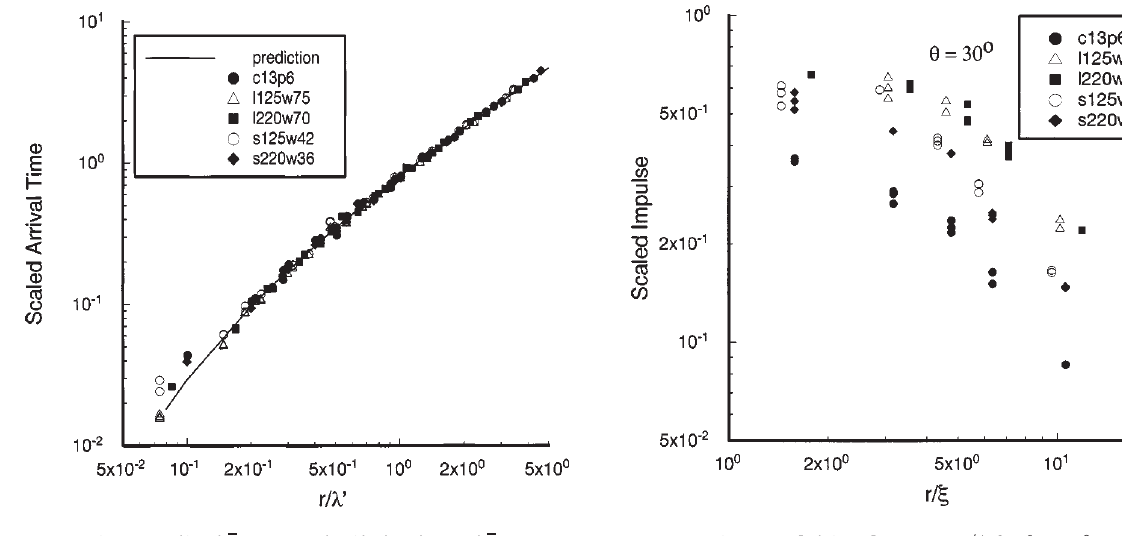
Fig. 5. Predicted t a compared with the observed t a . Fig. 6. Scaled impulse versus r/ξ for θ = 30 ◦